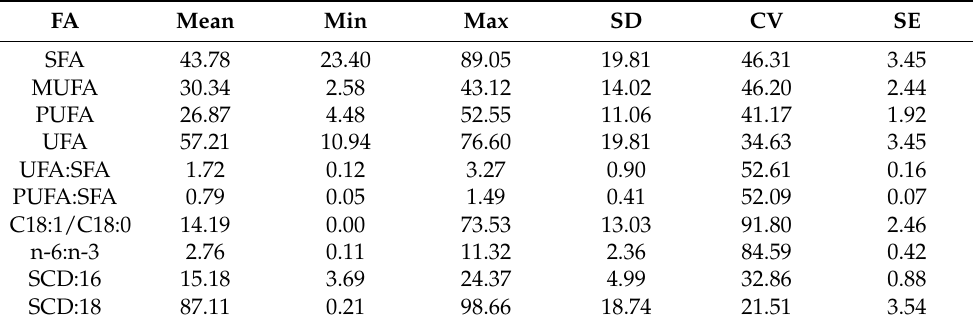
Table 3. The values of healthy fatty acids and ratios between fatty acids in mare’s milk.